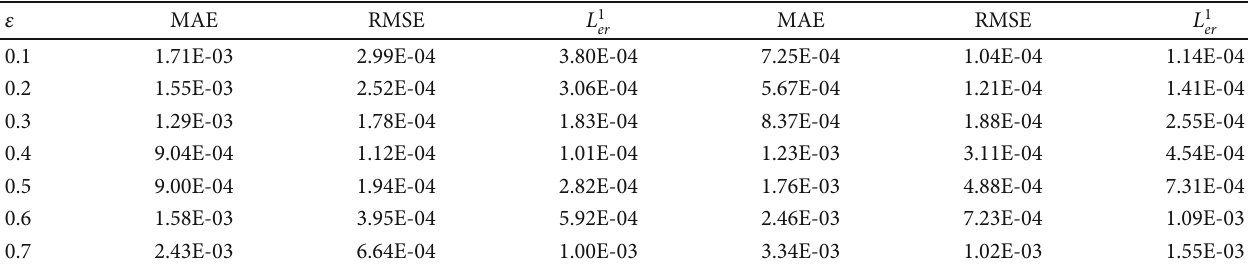
Table 6: Results for di ff erent values of ε in Example 2 with N conditions.